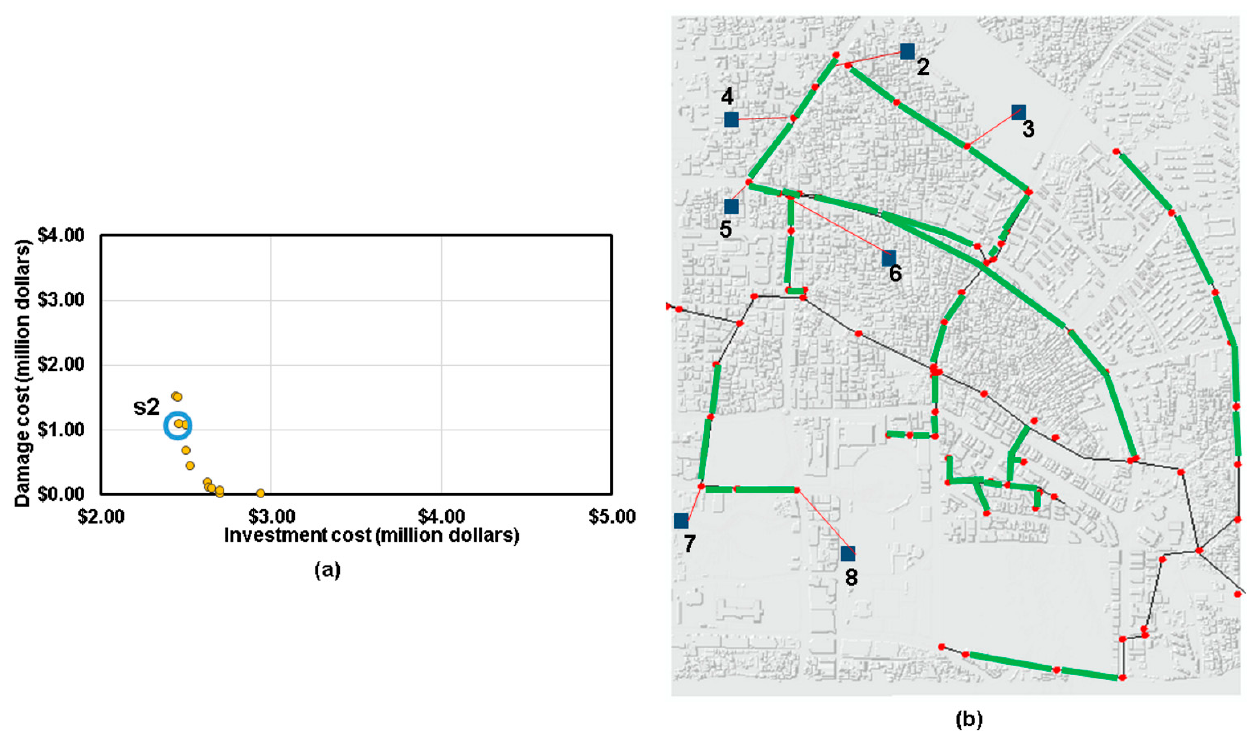
Figure 5. ( a ) The non-dominated optimal solutions implementing grey infrastructure. ( b ) Optimal solution (s2) of grey infrastructure, pipes to be replaced (green lines) and number and location of storage tanks (dark blue squares).